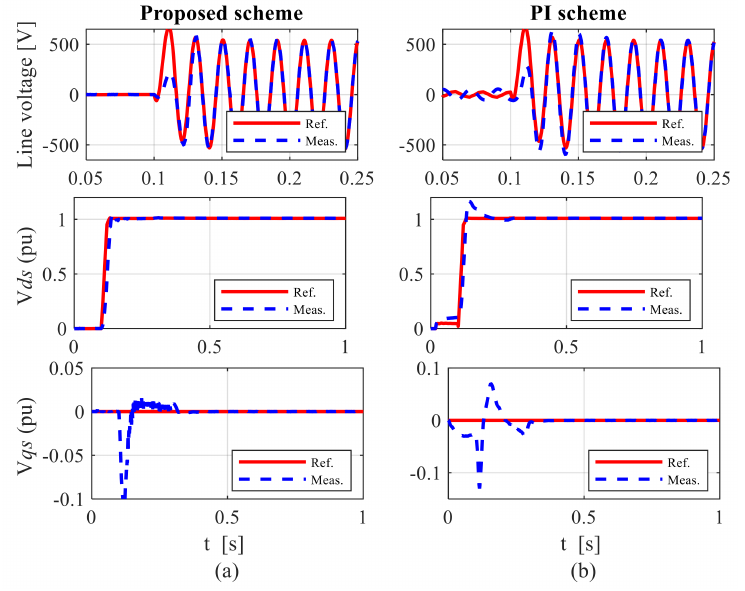
Figure 7. Control performances during sub-synchronous speed operation under balanced grid conditions for R r(perturbed) = 50% R r : ( a ) proposed scheme and ( b ) PI scheme.